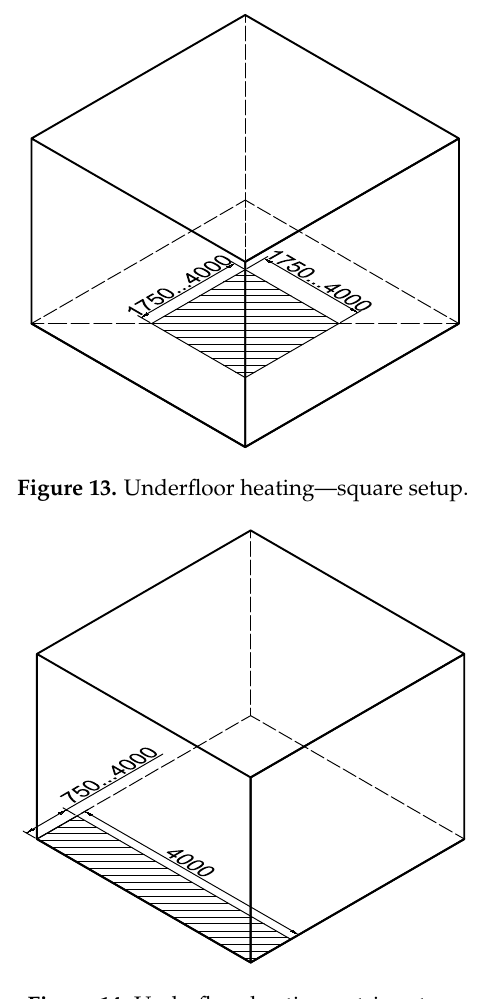
Figure 14. Underfloor heating—strip